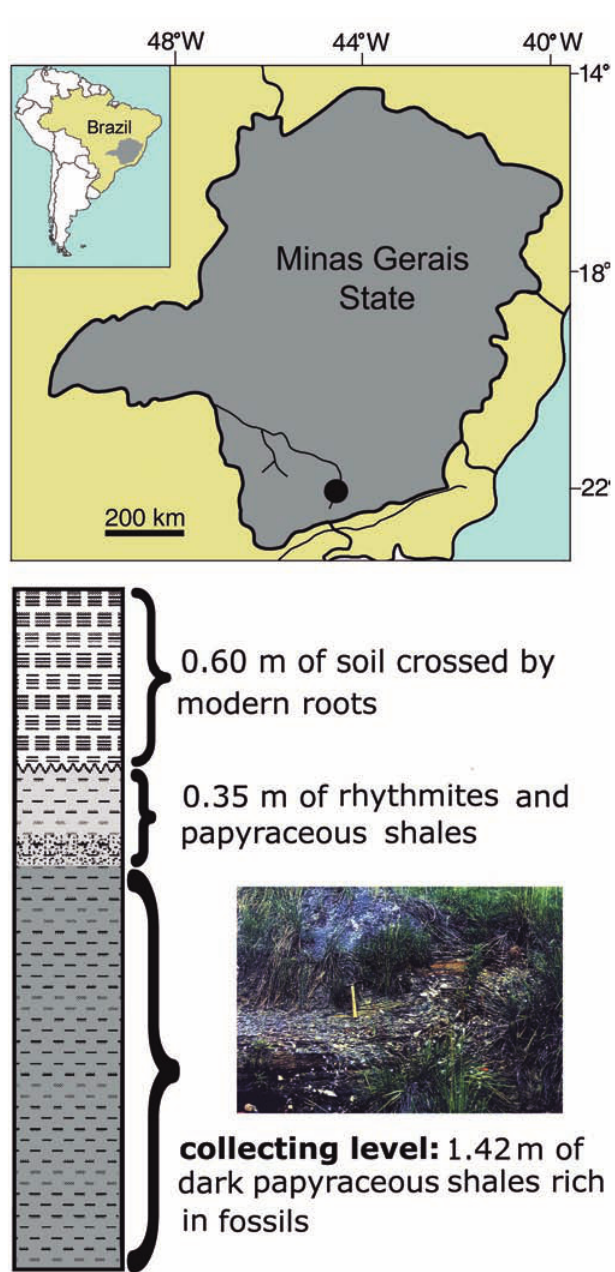
Fig. 1. Location map. A, map showing the location of the fossil site (black circle) in southern Minas Gerais State, south- eastern Brazil; B, stratigraphic column and image of the En- tre-Córregos Formation outcrop, type locality for † Bryconetes enigmaticus . Modified from Santos (1999) and Castro- Fernandes et al.